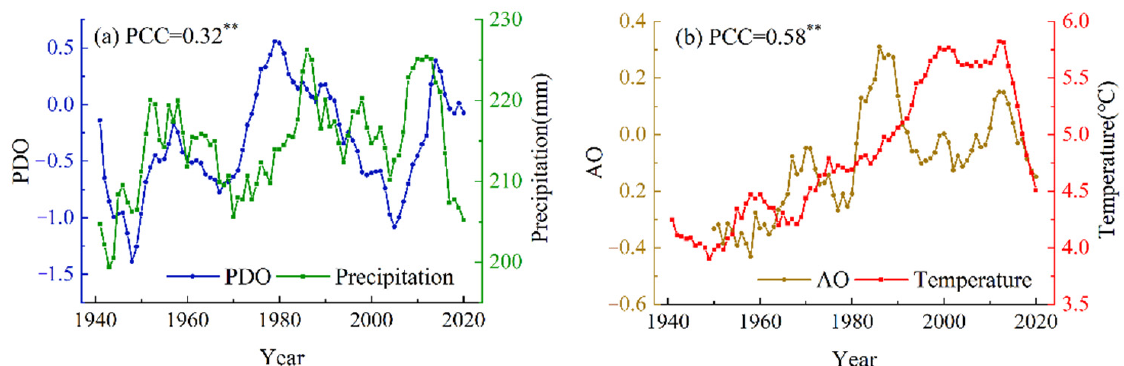
Figure 6. Correlations between precipitation and PDO ( a ), and correlations between temperature and